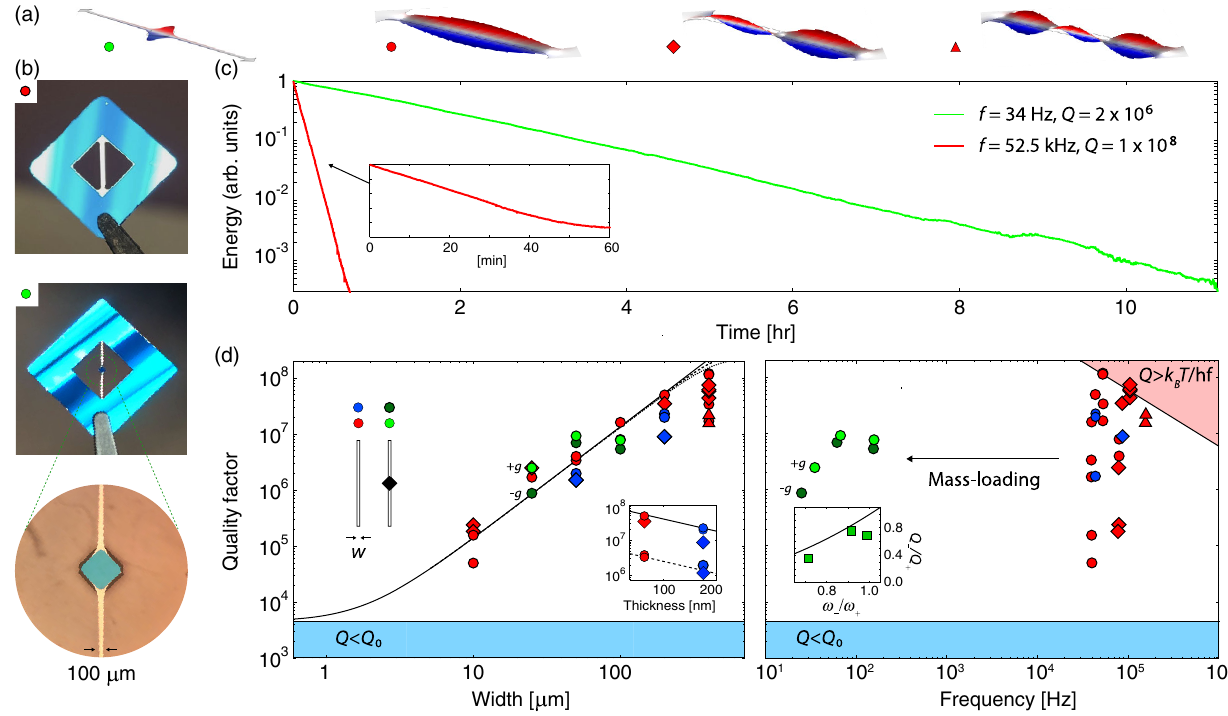
FIG. 2. Ultralow-loss nanomechanical torsion resonators. (a) Simulated torsion modes of a nanoribbon with (green) and without (red) mass loading. (b) Photos of representative devices: (top) a 400 - μ m-wide, 7-mm-long, 75-nm-thick ribbon; (middle) a 25 - μ m-wide, 7-mm-long, 75-nm-thick ribbon loaded with a 100 - μ m-thick Si paddle; and (bottom) a micrograph of the paddle. (c) Ringdowns of the fundamental mode of a 400 - μ m-wide ribbon (red) and a mass-loaded, 25 - μ m-wide ribbon (green). (d) Compilation of Q versus ribbon width (left) and frequency (right). Red and blue points correspond to thicknesses of 75 and 180 nm, respectively. Dark and light green points correspond to inverted ( − g ) and noninverted ( þ g ) chip orientations, respectively. Solid, dashed, and dotted curves correspond to 1 . 1 × 10 9 [21], respectively. Left inset: Q versus the lumped mass model, finite element model, and a gas damping model with Q gas ¼ thickness for 200- and 50 - μ m-wide beams, compared to the lumped model (solid and dashed lines). Right inset: Q versus frequency for mass-loaded ribbons of different orientation, compared to Eq. (4) (solid